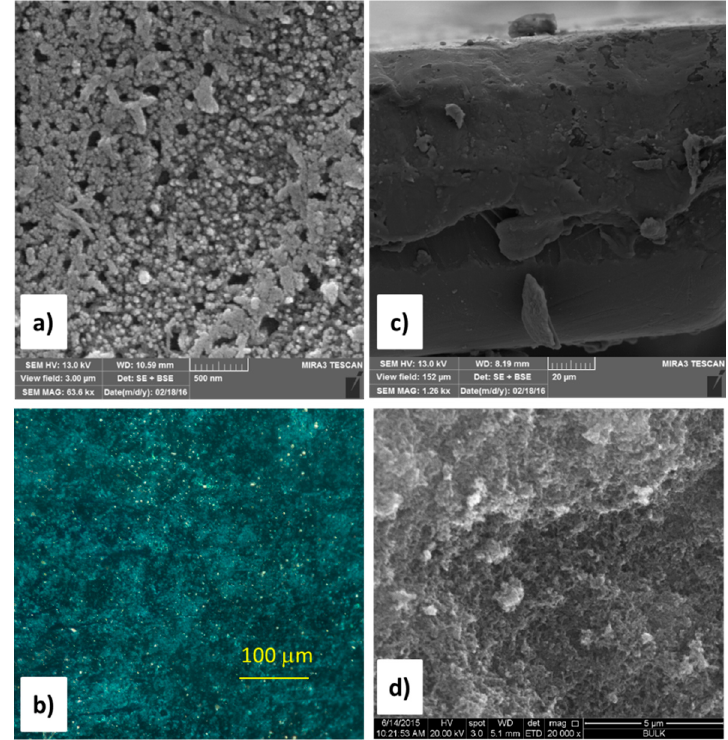
Figure 2. SEM images for the surface of PANI-PSU-20 ( a ); cross-section of the same membrane PANI-PSU-20 ( c ); and polyaniline nanofibers collected from the same reaction ( d ); Optical images in the dark field mode for PANI-PSU-20 ( b ).